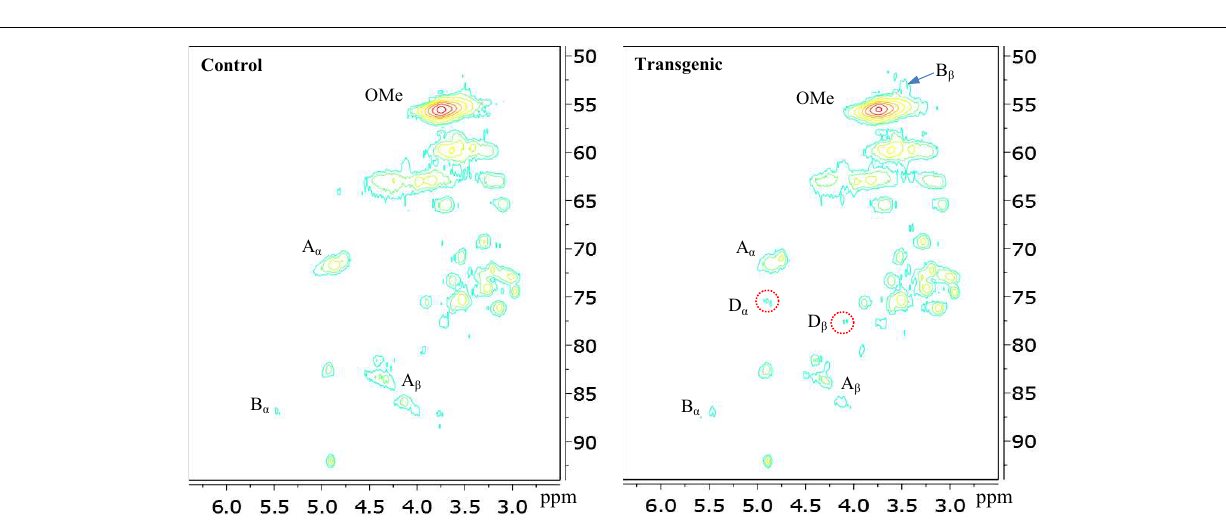
FIGURE 4 |Aliphatic regions of 13 C- 1 H HSQC spectra of enzyme lignins isolated from control and transgenic internode I1 switchgrass . A, β - O -4 ether; B, phenylcoumaran; D, benzodioxane; OMe,